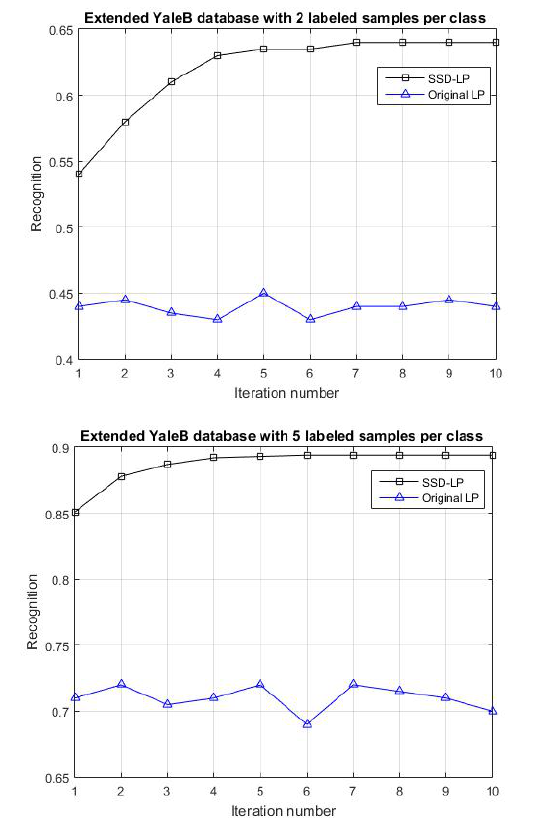
Fig. 3 Recognition rate versus iteration number for the Extended YaleB database with two labeled training samples per person (up) and five training samples per person (bottom).